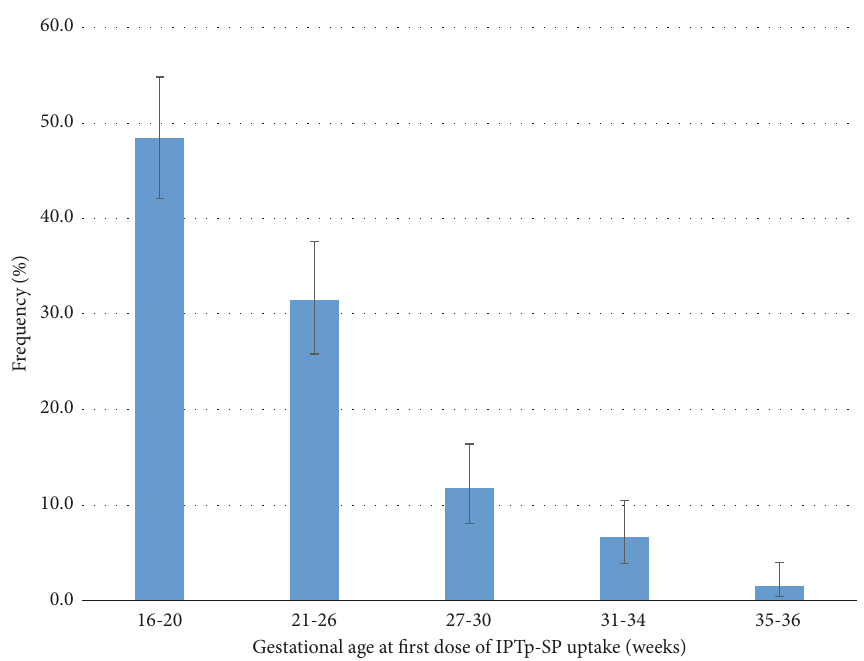
Figure 2: Gestational age at first dose of IPTp-SP uptake among women that had recently delivered at the Navrongo War Memorial Hospital in rural northern Ghana. The points plotted (-) indicate the percentage of mothers who took the first dose at the particular gestational age, while the vertical lines show the corresponding 95% confidence